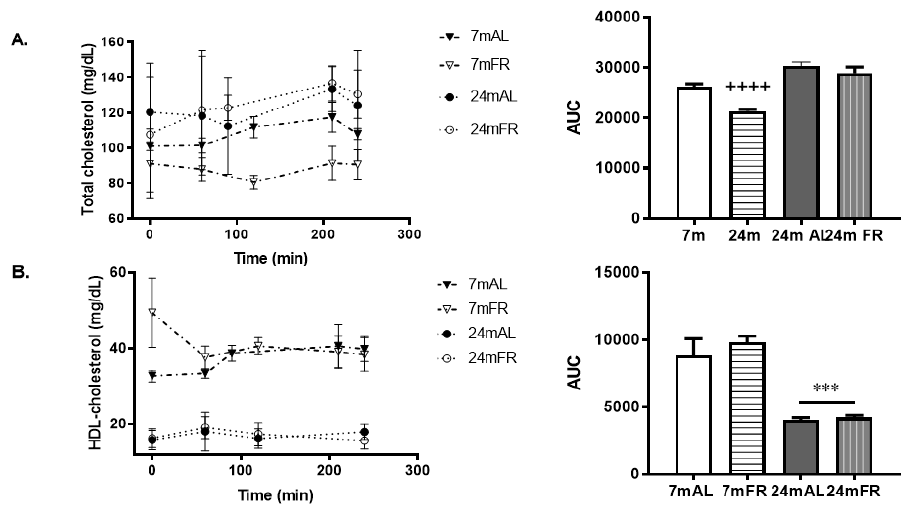
Figure 3. Evolution of serum total cholesterol ( A ) and HDL-cholesterol ( B ) levels in the 7- and 24-month-old rats fed ad libitum (AL) or food restricted (FR), after an oral lipid loading test (OLLT). Blood aliquots from the tail vein were taken at 0, 30, 60, 90, 120, 180, and 240 min after the OLLT. The serum samples obtained by blood centrifugation at each time were pooled and used for the measurement of hormones and metabolites, conducted in duplicates. Results are the mean ± SEM of 8–10 rats per group. Overall changes in the total cholesterol and HDL-cholesterol levels during the oral lipid loading test were calculated as the area under the curve (AUC) above the basal level. Unpaired Student’s t -test, *** p ≤ 0.001 compared to the 7-month-old rats under the same feeding protocol; ++++ p ≤ 0.0001 compared to the age -matched ad-libitum-fed rats.